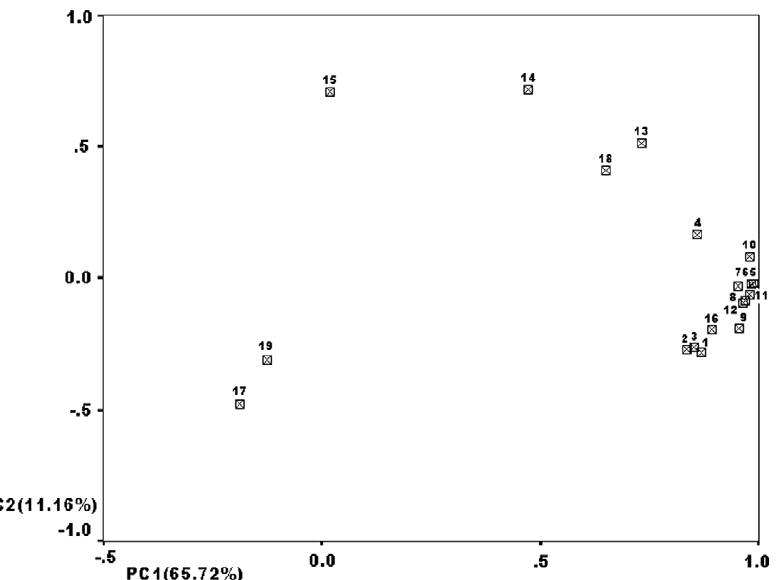
Figure 3. The two-dimensional graphs of Y-STR frequencies. This map accounts for 76.88% of the original genetic variation. The three EC high-risk populations and Manchu form 2 clusters; the three Northern Han (labeled 10–12) and five Southern Han populations (labeled 5–9) form another group. The remaining populations are scattered. 1, Chaoshan EC high-risk population; 2, Fujian EC high-risk population; 3, Henan Taihang Mountain EC high-risk population; 4, Fujian Han; 5, Anhui Han; 6, Yunnan Han; 7, Henan Han; 8, Zhejiang Han; 9, Guangzhou Han; 10, Dongbei Han; 11, Beijing Han; 12, Tianjing Han; 13, Tibetan; 14, Uygur; 15, Krigiz; 16, Manchu; 17, Shui; 18, Naxi; 19, Zhuang. 4–9 refer to Southern Hans, 10–12 to Northern Hans, 13–17 to Northern minority nationalities, 18–19 to Southern minority